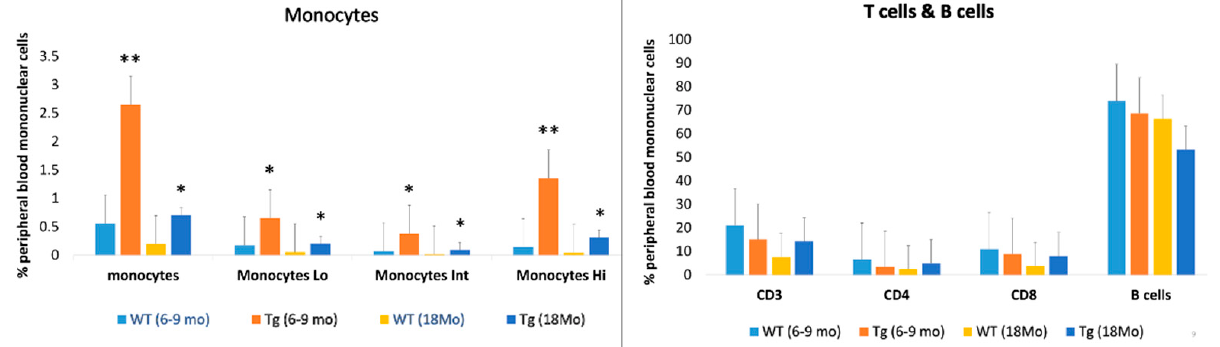
Figure 7. Comparison of monocytes, T cells, and B cells in CAG-HtrA1 Tg mice and wild-type control aged between 6–9 months and 18 months. Monocytes are significantly higher in the Tg mice while there is no significant difference in the T cells and B cells between the mice groups. Tg and WT mice. ( n = 4 each) were used for the comparison of population of granulocytes including monocytes and the Mann–Whitney U test was performed. Significance level was defined as ** p < 0.01 and * p < 0.05.